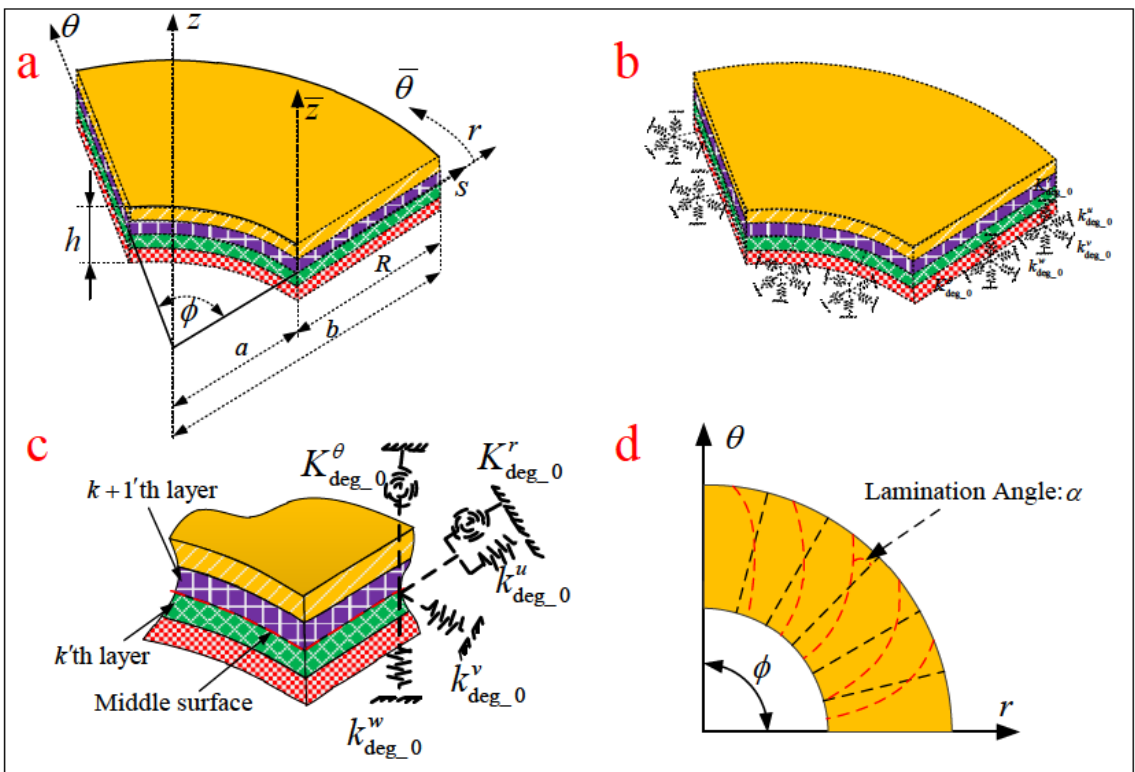
Figure 1: Schematic diagram of a moderately thick composite annular sector plate with elastically restrained edges: (a) geometry and di- mensions; (b) partial boundary spring; (c) partial view; (d) lamination